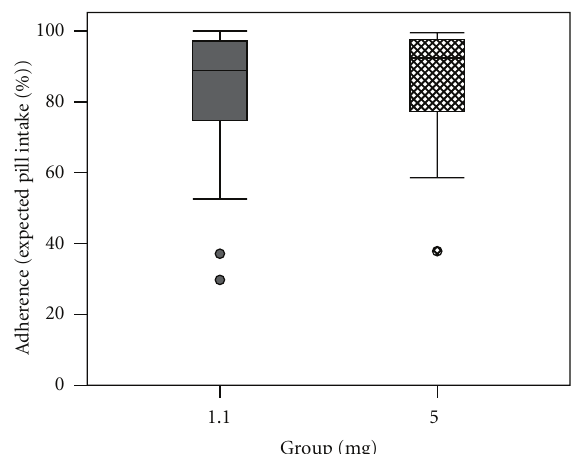
Figure 6: Rates of adherence to multivitamin supplementation.